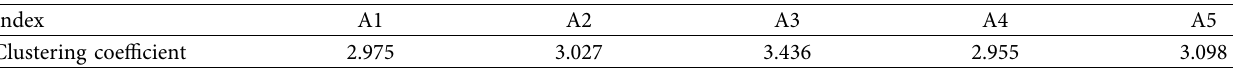
Table 7: Clustering coefficients for each level of Port A.